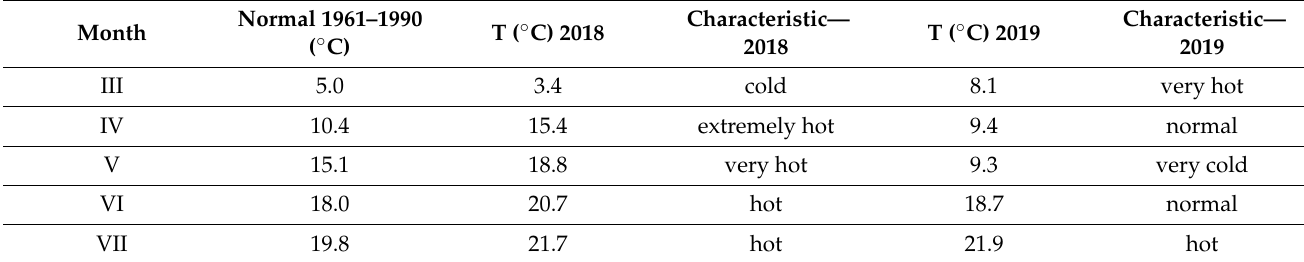
Table 3. Evaluation of months according to air temperature climate normals 1961–1990.